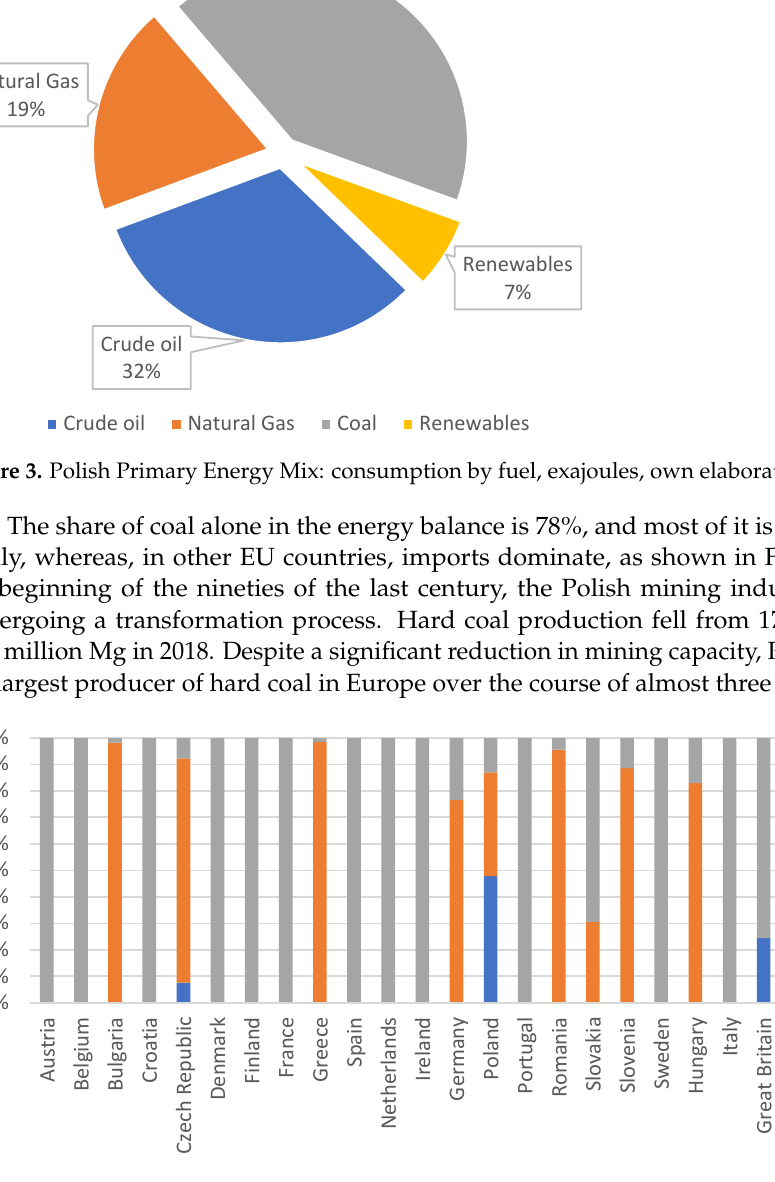
Figure 4. Amount of coal in Europe, own-elaboration-based [15].